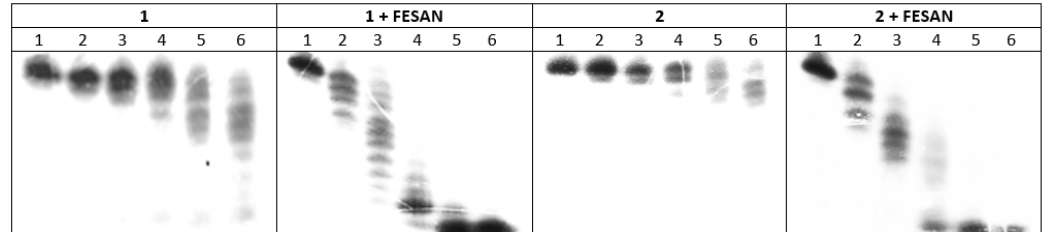
Figure 7. Autoradiograms after denaturing PAGE, showing the products of svPDE-promoted hydrolysis of 32 P- labeled oligonucleotides 1 or 2 mixed with metallacarborane ferra(III) bis(dicarbollide) (6 molar equivalents relative to ASO). Lanes 1 to 6 represent the products present in aliquots of the hydrolysis reaction taken at 0, 5, 15, 30, 60 and 90 min, respectively.